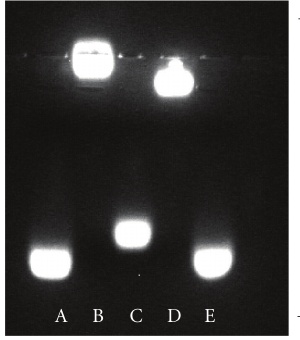
Figure 3: Luminescence image set of 540 nm emitting CdSe–ZnS QD with DHLA–PEG600 :DHLA–TEG–Biotin (4:1) at pH 5.5 ∼ 9 in phosphate bu ff er saline at various pH values at room tempera- ture. Samples were excited with a handheld UV lamp at 365